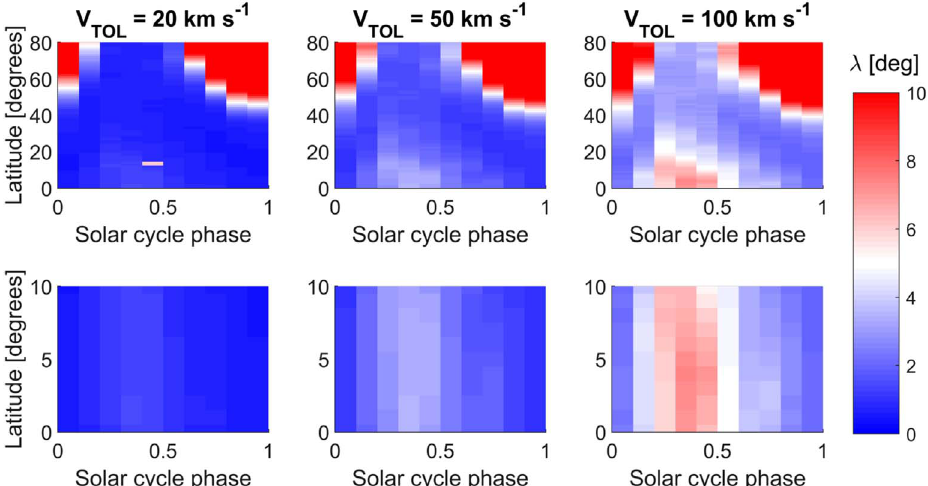
Fig. 8. The localisation parameter, k , in degrees, as a function of latitude and solar cycle phase. Note the colour bar has been saturated at 10 (cid:1) to highlight the variations in smaller values. Top: the full latitude range. Bottom: a detail of ±10 (cid:1) . Columns, from left to right, show speed error tolerances of V TOL = 20, 50, and 100 km s (cid:3) 1 ,